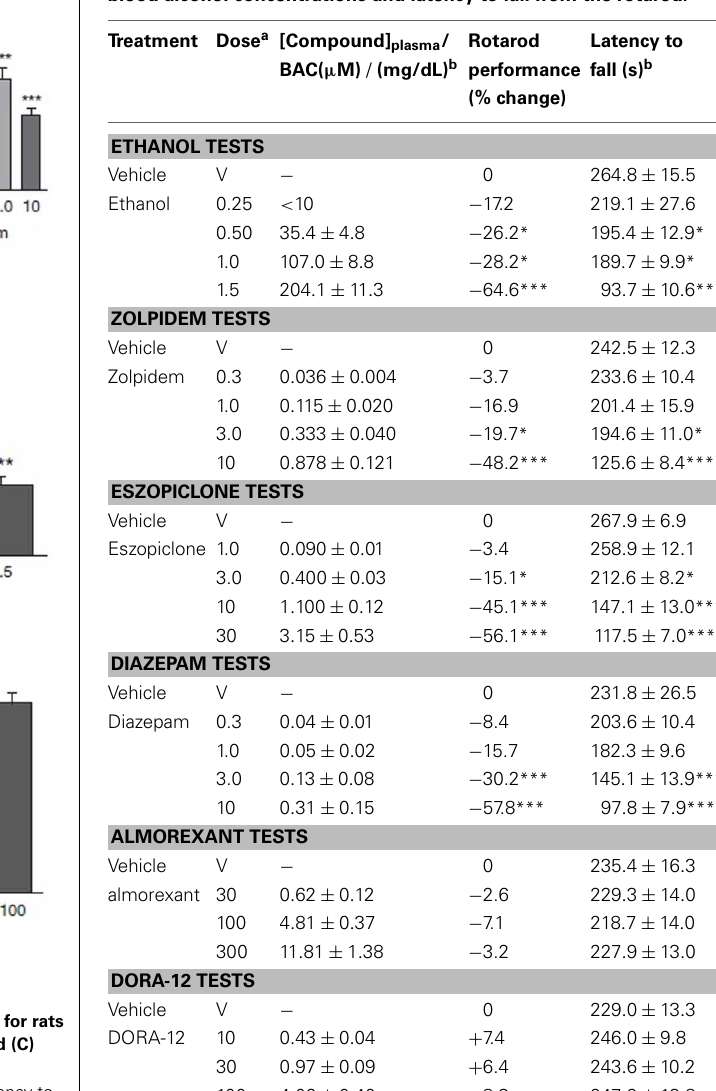
Table 1 | Dose-response effects of ethanol, GABA-A receptor modulators and orexin receptor antagonists on compound plasma or blood alcohol concentrations and latency to fall from the rotarod.